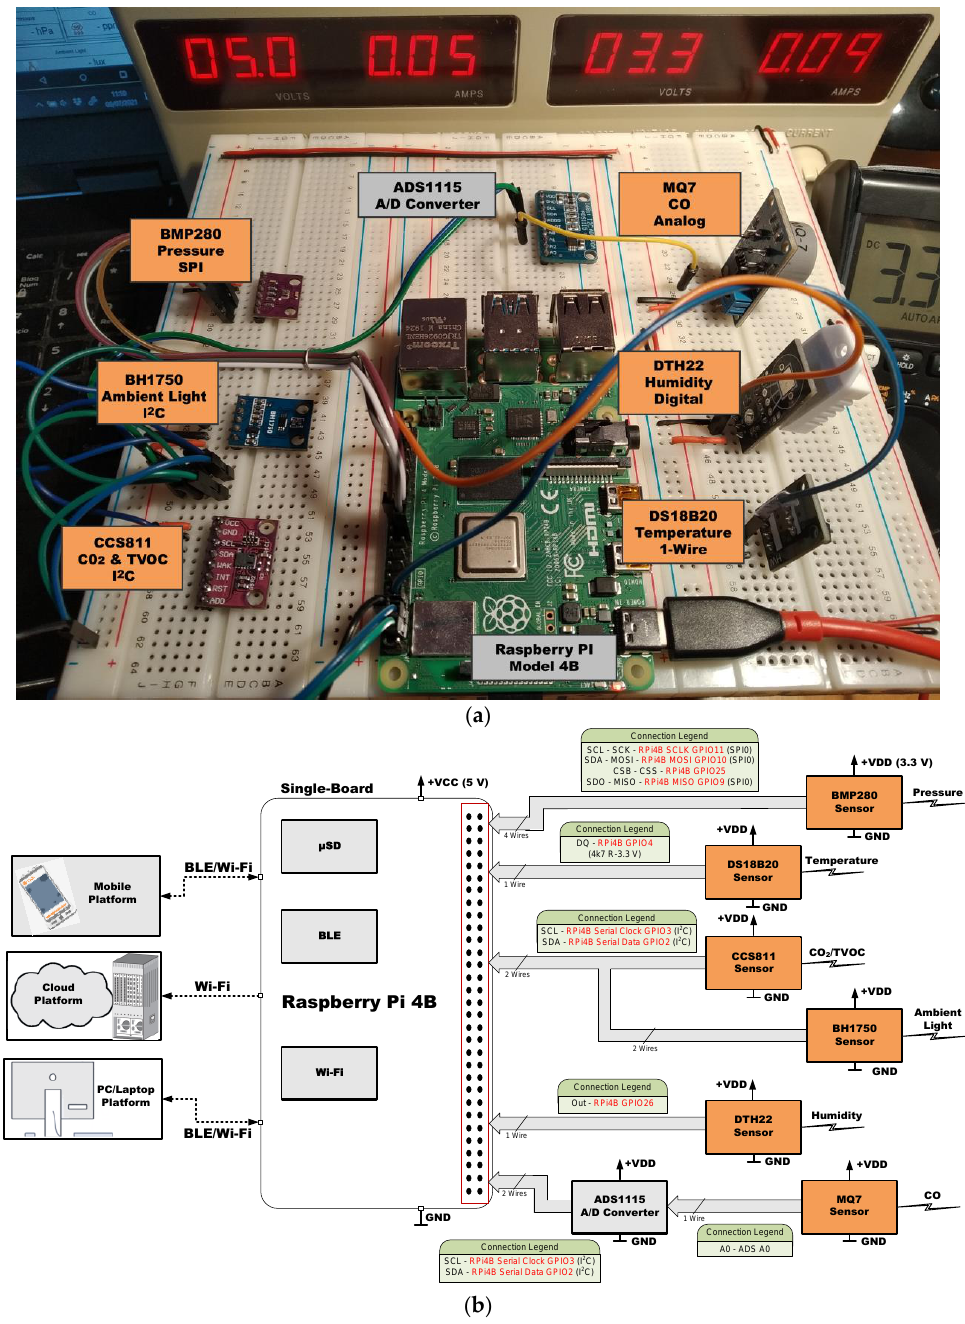
Figure 5. SBC Raspberry Pi 4 B in experimental framework ( a ) and hardware connections ( b ) [150].